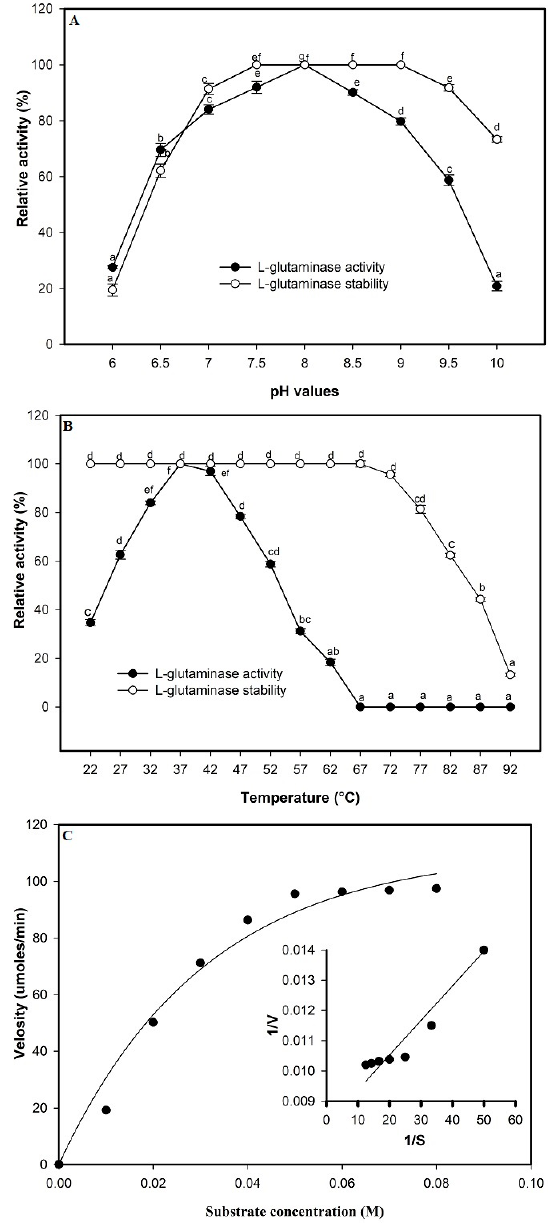
Figure 9. Kinetic parameters of purified L-glutaminase. Effect of pH ( A ) and temperature ( B ), on L-glutaminase activity and stability. Mean ± standard error ( n = 3) is presented. Vertical bars indicate the standard errors of the means. Means followed by different letters are significantly different at p < 0.05. The reaction velocities (V) vs. substrate concentration fitted to the Michaelis-Menten equation and determination of the Km and Vmax values of the purified enzyme by Lineweaver–Burk plot ( C ).